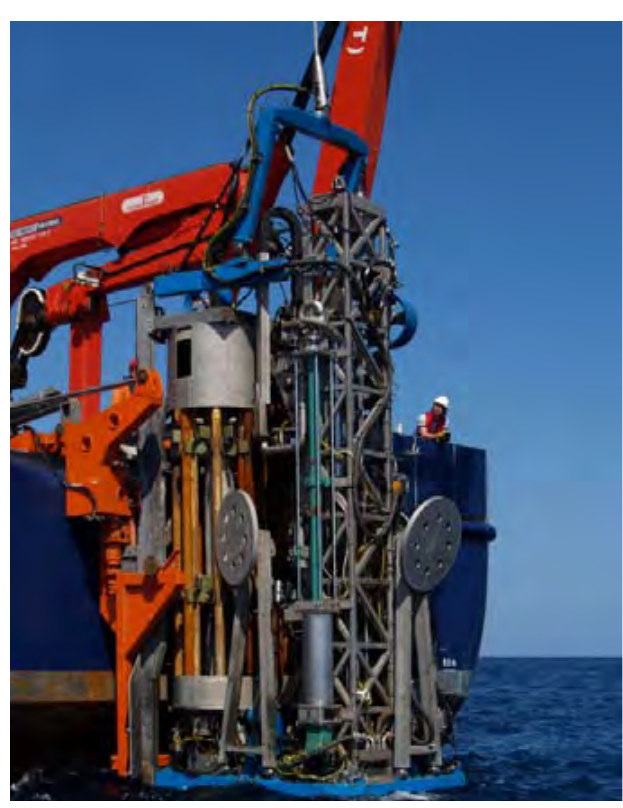
Figure 5. Launch of the sea floor drill rig MeBo from the Maria S. Merian